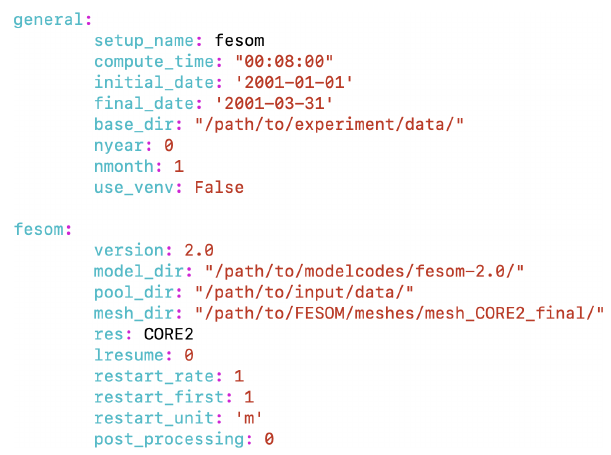
Figure 2. Run configuration for a short run of